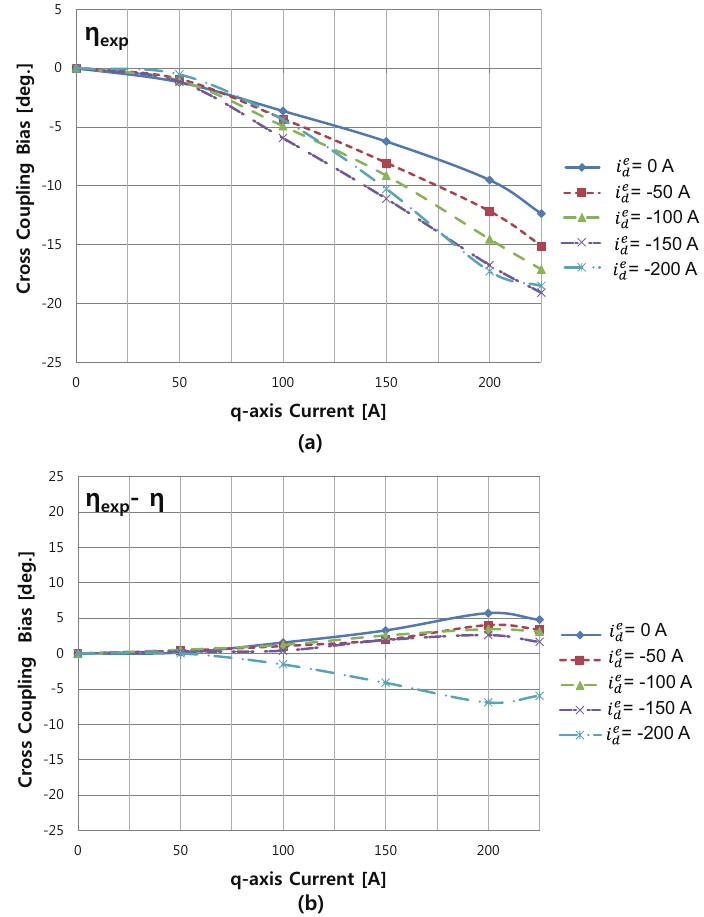
Figure 13. ( a ) Experimental angle offset due to the cross-coupling inductance and ( b ) The differences between the angle offset measured η exp and the angle offset calculated η using FEM